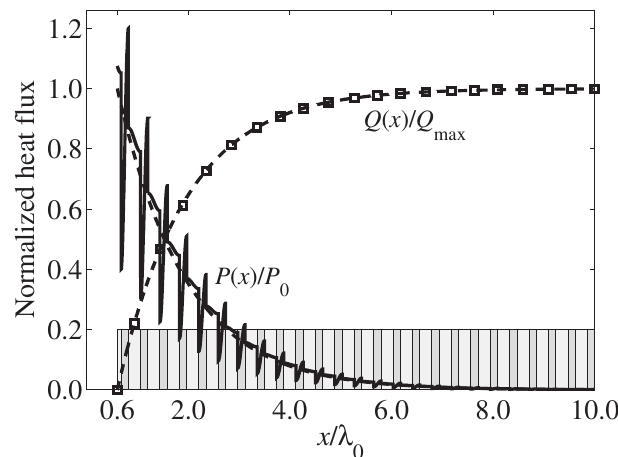
FIG. 7. Temperature profile of different values of h in the silica-silicon structure, the parameters of which are given in Table II. For each value of h , the dashed line is the approximate curve, and the exact solution is indicated by square markers. The dissipated power profiles, approximate (dashed line) and exact (solid line), are also plotted. All quantities are normalized by their maximal approximate value.